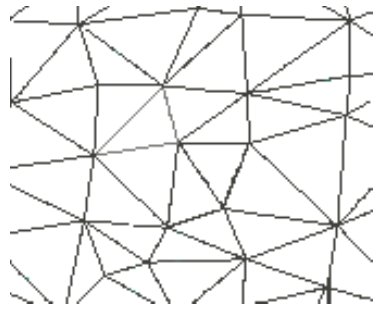
Figure 9. An irregular triangular mesh established by point cloud data.